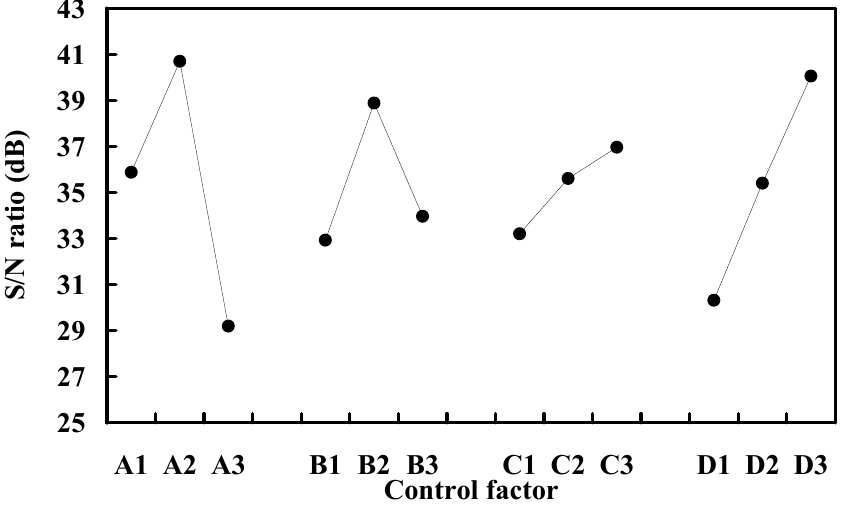
Figure 9. S/N ratio effects of each process control factor.